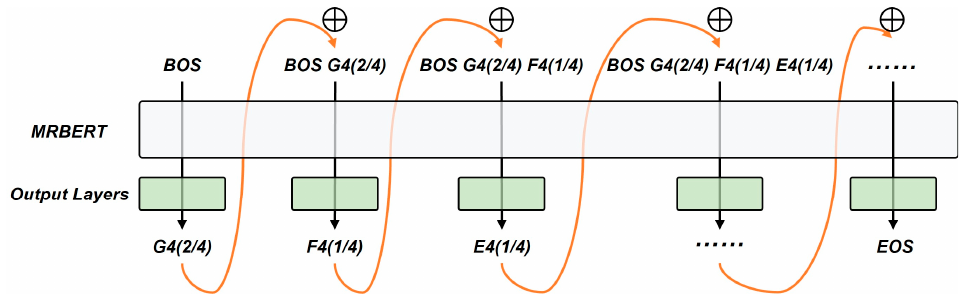
Figure 3. Pipeline of autoregressive generation. The orange arrows represent the predicted melody and rhythm should be continuously added to the end of the input. and rhythm should be continuously added to the end of the